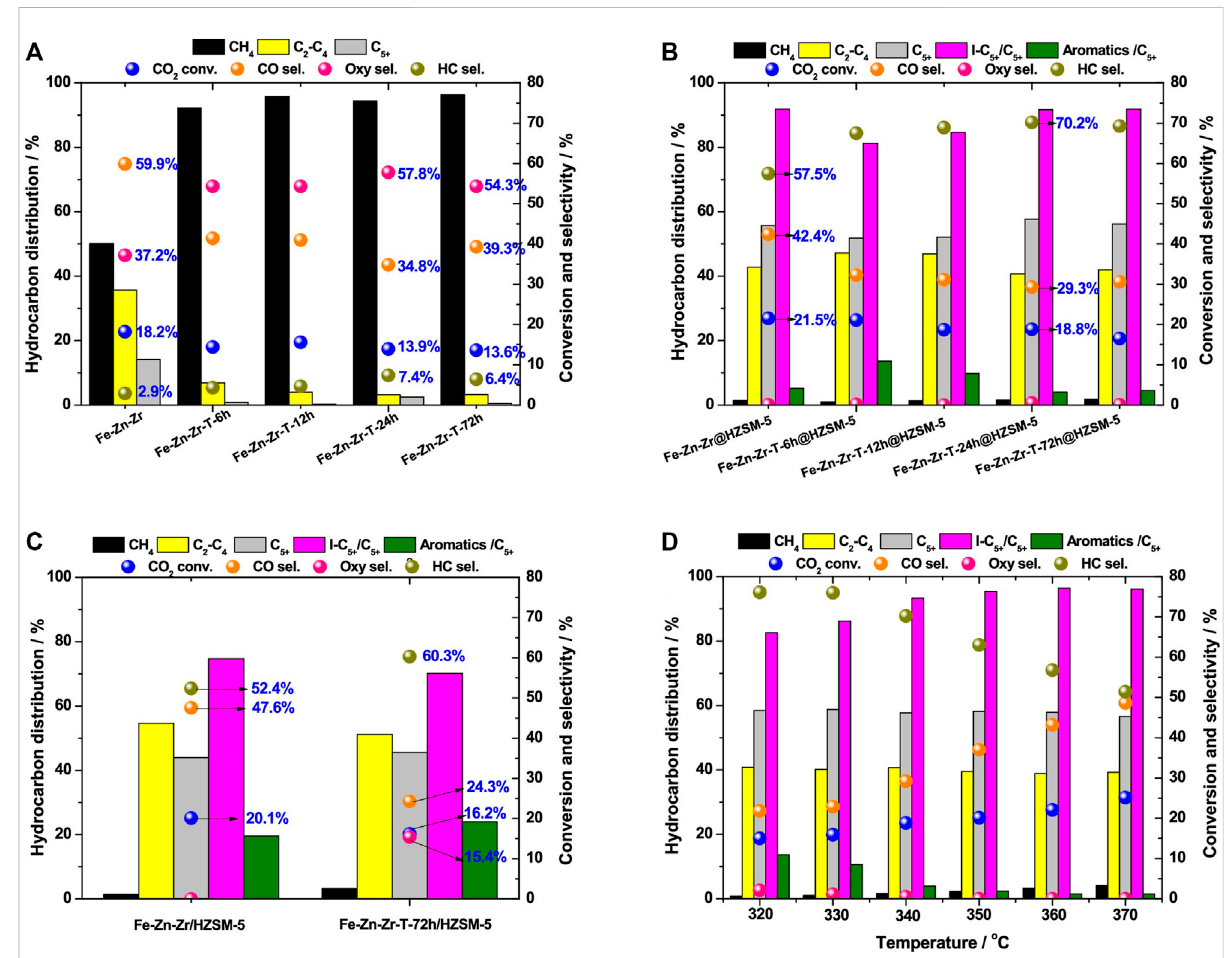
FIGURE 3 CO 2 conversion and selectivity for various products over different catalysts (Wang et al., 2021b). (A) Fe-Zn-Zr and Fe-Zn-Zr-T-x oxides. (B) Fe- Zn-Zr@HZSM-5 and Fe-Zn-Zr-T-x@HZSM-5 core shell. (C) Fe-Zn-Zr/HZSM-5 and Fe-Zn-Zr-T-72 h/HZSM-5 granular mixing. (D) Fe-Zn-Zr-T- 24 h@HZSM-5 core shell under different reaction